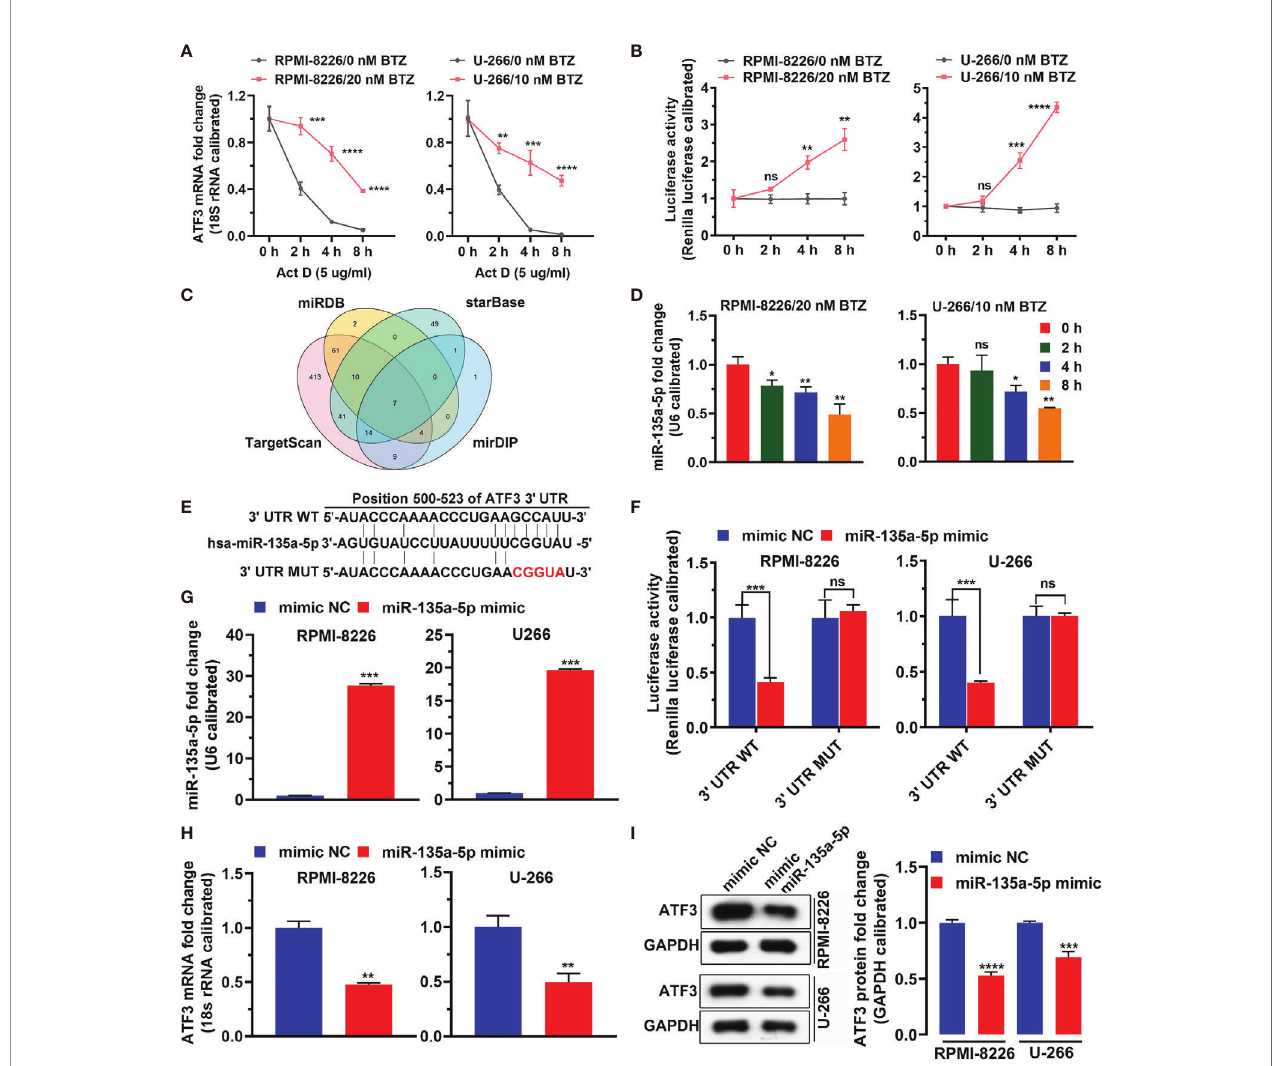
FIGURE 3 | MiRNA regulates ATF3 after BTZ treatment. (A) Dynamic level of the ATF3 mRNA change after actinomycin D (Act D) treatment at various doses. Data was analyzed by one-way ANOVA, followed by Tukey ’ s post-hoc test. **P < 0.01, ***P < 0.001, and ****P < 0.0001. (B) Luciferase activity of ATF3 after Act D treatment at various doses. Data was analyzed by one-way ANOVA, followed by Tukey ’ s post-hoc test. **P < 0.01, ***P < 0.001, and ****P < 0.0001. (C) Venn plot of common miRNAs that target ATF3 in TargetScan, miRDB, mirDIP, and DIANA databases. (D) Expression of miR-135a-5p was measured by RT-qPCR in cells treated with BTZ. Data were analyzed by one-way ANOVA, followed by Tukey ’ s post-hoc test. Ns, no signi fi cance; *P < 0.05, and **P < 0.01 compared with 0 h (E) Conserved and mutant binding sites between the ATF3 3 ′ UTR and miR-135a-5p. (F) Dual luciferase reporter assay showing reduced luciferase reporter activity in MM cells that contained the ATF3 3 ′ UTR WT fragment. (G) MiR-135a-5p mimics increased miR-135a-5p expression assessed by RT-qPCR. (H) The ATF3 mRNA level was reduced by miR-135a-5p mimic transfection as assessed by RT-qPCR. (I) Left panel: The ATF3 protein level was reduced by miR-135a-5p mimic transfection in cell lines as measured by western blotting. Right panel: Quanti fi cation of ATF3 band intensity, with values normalized to GAPDH. Data are all presented as the mean ± SD. Differences between two groups were analyzed by the Student ’ s t-test. *P < 0.05, **P < 0.01, ***P < 0.001, ***P < 0.0001. ns, no signi fi cance. NC, negative